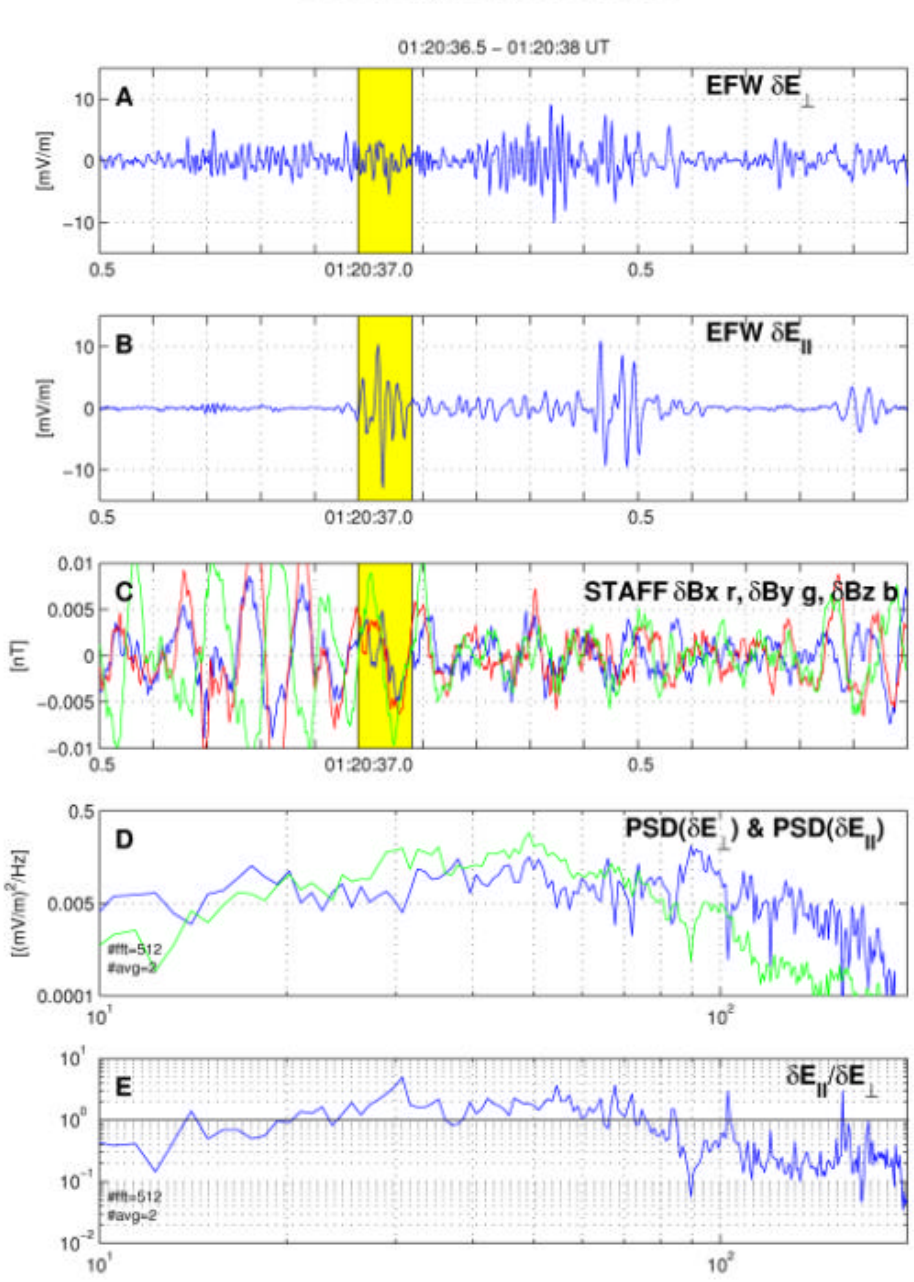
Fig. 4. Data from Cluster spacecraft 3 during part of the interval in Fig. 2; the panels are similar to Fig. 3. Wave bursts with large parallel electric fields are observed. The interval indicated in yellow is studied in detail in Fig.